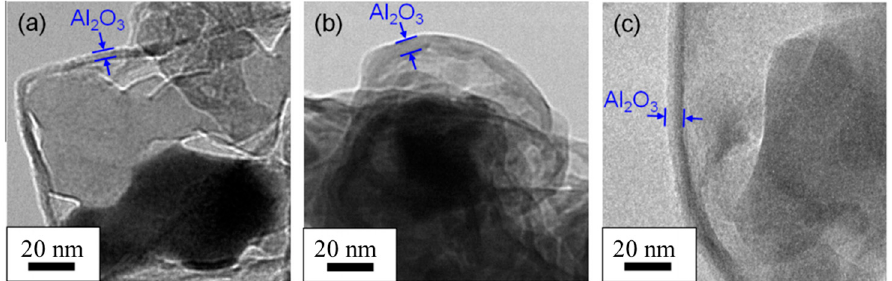
Figure 11. The TEM images of Al 2 O 3 films on AlH 3 particles; ( a ) without exposure to air, ( b ) 1 day after exposure to air, and ( c ) 7 days after exposure to air. Reprinted with permission from Ref. [5]. Copyright 2013 Elsevier.